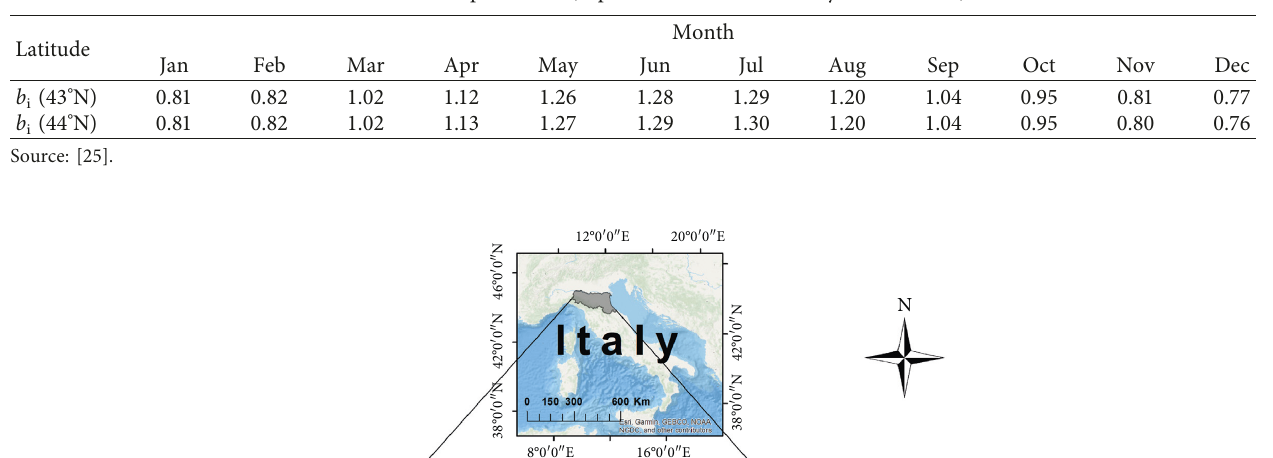
Table 1: Sunshine parameter (expressed in units of 30 days of 12 hours).